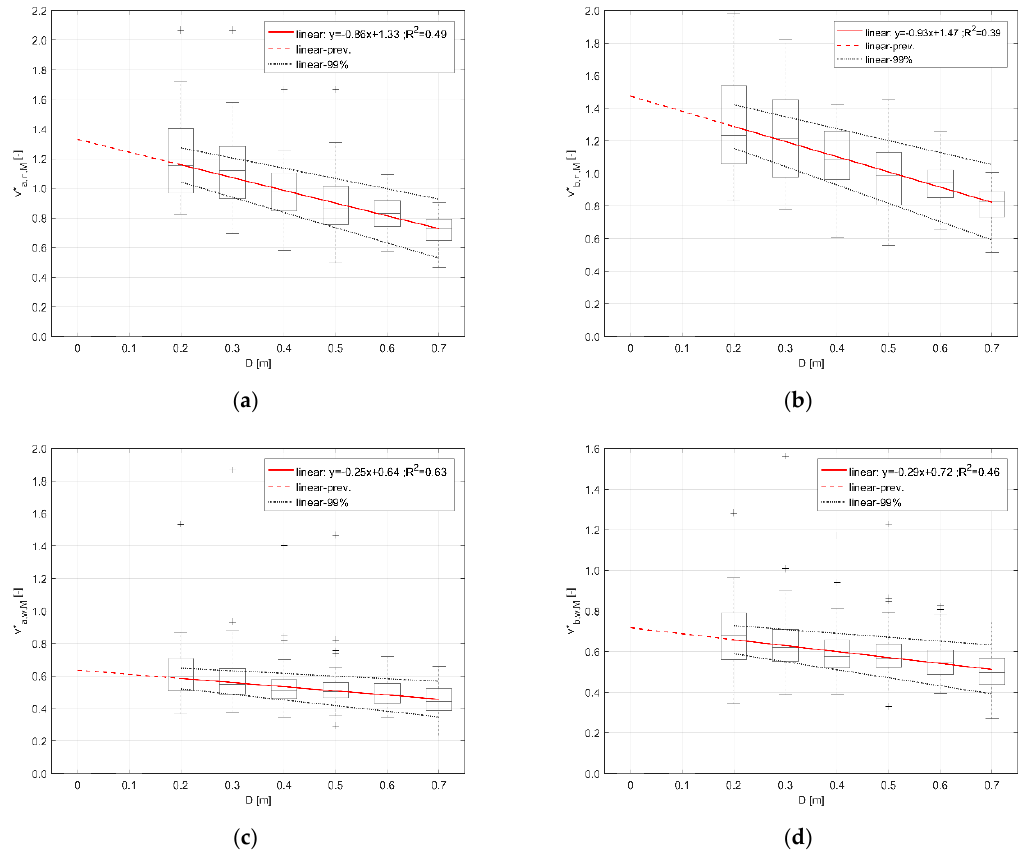
Figure 7. Normalized speed variation depending on D in respect to dry surface motion conditions, for the male sample: ( a ) for running conditions, according to the curve a [46]; ( b ) for running conditions, according to the curve b [43]; ( c ) for walking conditions, according to the curve a [46]; ( d ) for walking conditions, according to the curve b [43]. Linear regressions (dashed lines refer to expected values outside of the tested D range) and boundary conditions (99%) are shown. Outliers are shown in the boxplot representation (marked by “+”).